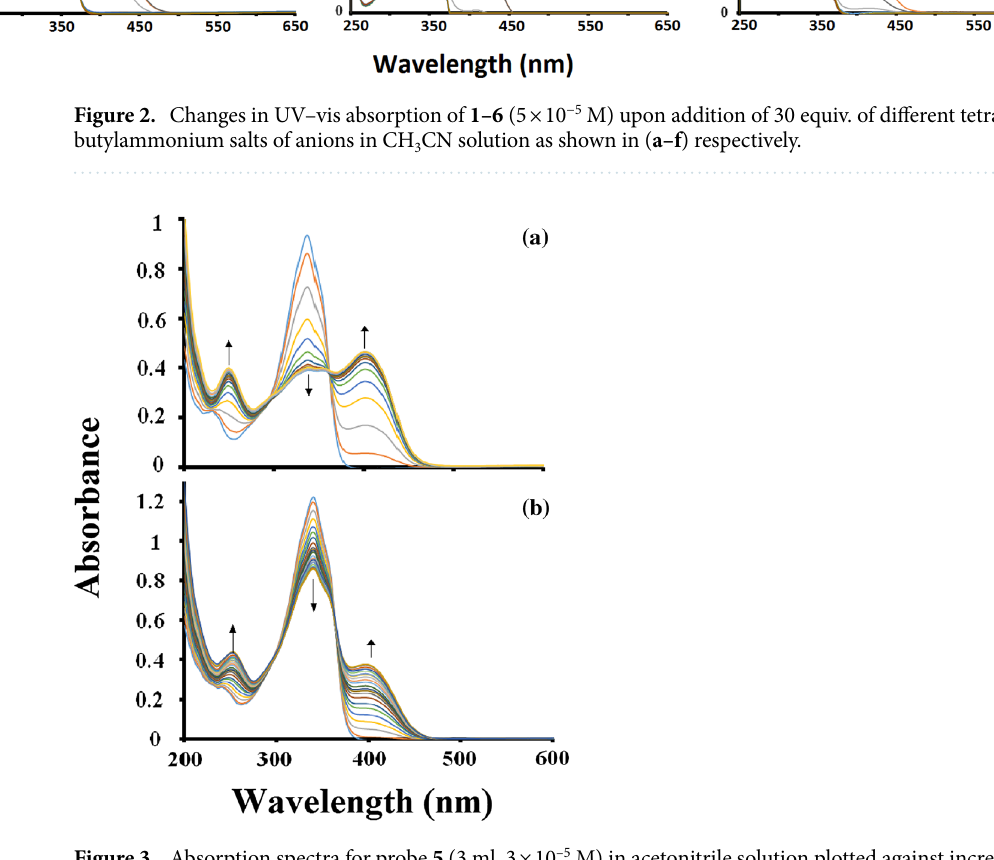
Figure 3. Absorption spectra for probe 5 (3 ml, 3 × 10 –5 M) in acetonitrile solution plotted against incremental addition (0–10 equiv.). ( a ) Fluoride anions and ( b ) acetate anions.